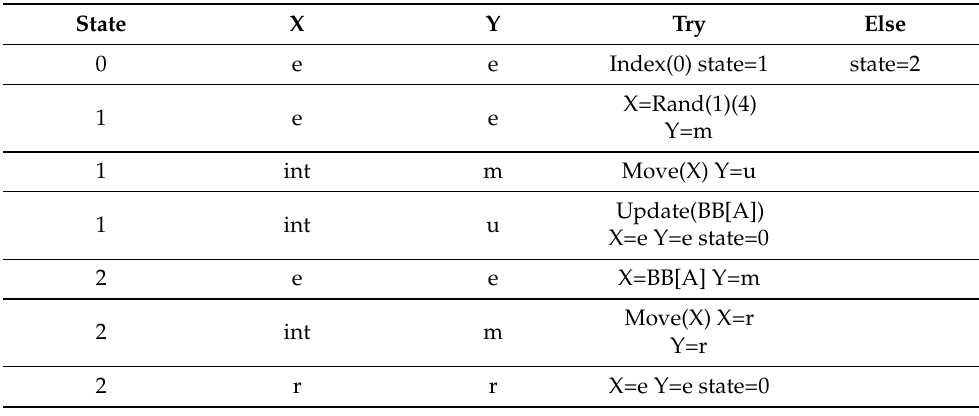
Table 3. A simple swarm optimization algorithm, the definition of the rules.